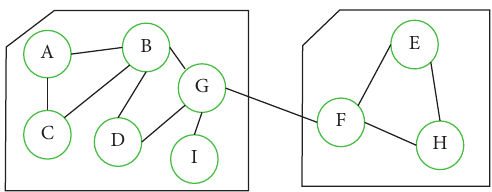
Figure 3: Remodularization of Figure